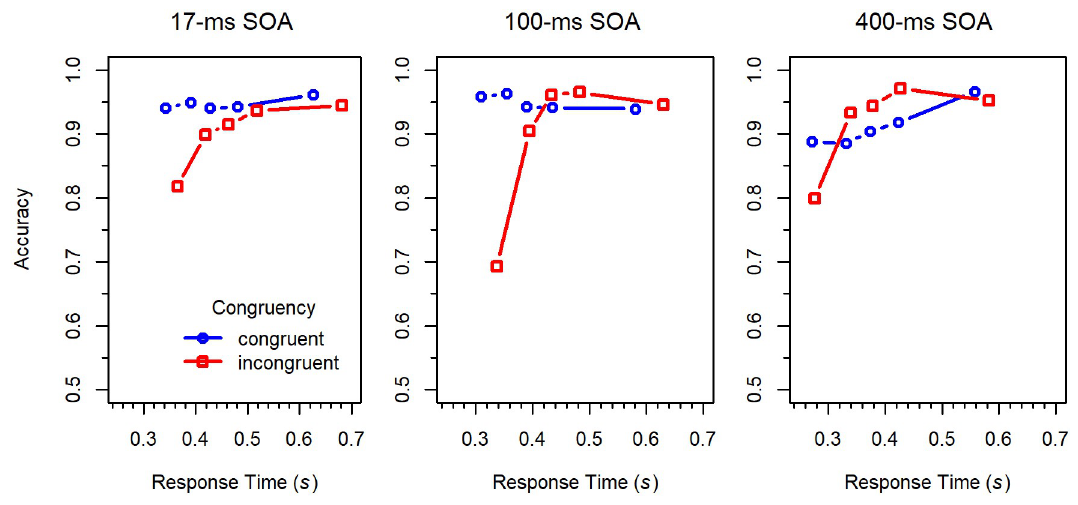
Fig 3. Conditional accuracy functions for the different conditions in Experiment